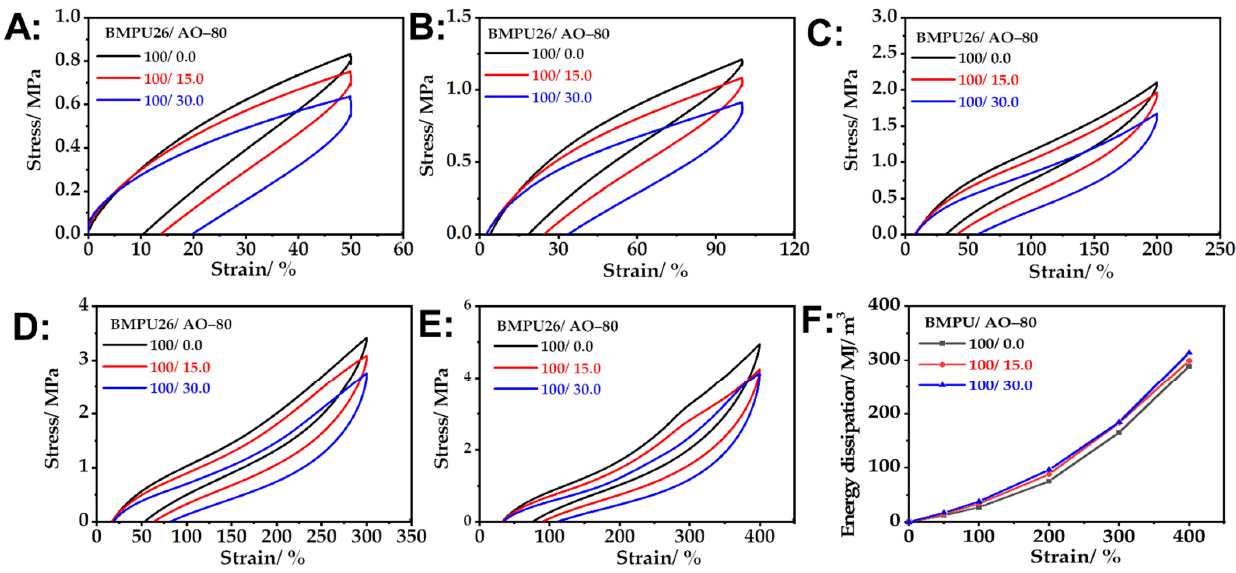
Figure 6. Tensile loading–unloading curves of the BMPU/AO-80 composites at strains of ( A ) 50%, ( B ) 100%, ( C ) 200%, ( D ) 300%, and ( E ) 400%. ( F ) Energy dissipation of the BMPU/AO-80 composites.